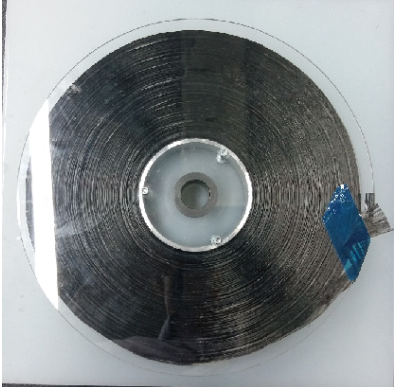
Figure 5. Spreading roll of carbon fibers of sizing